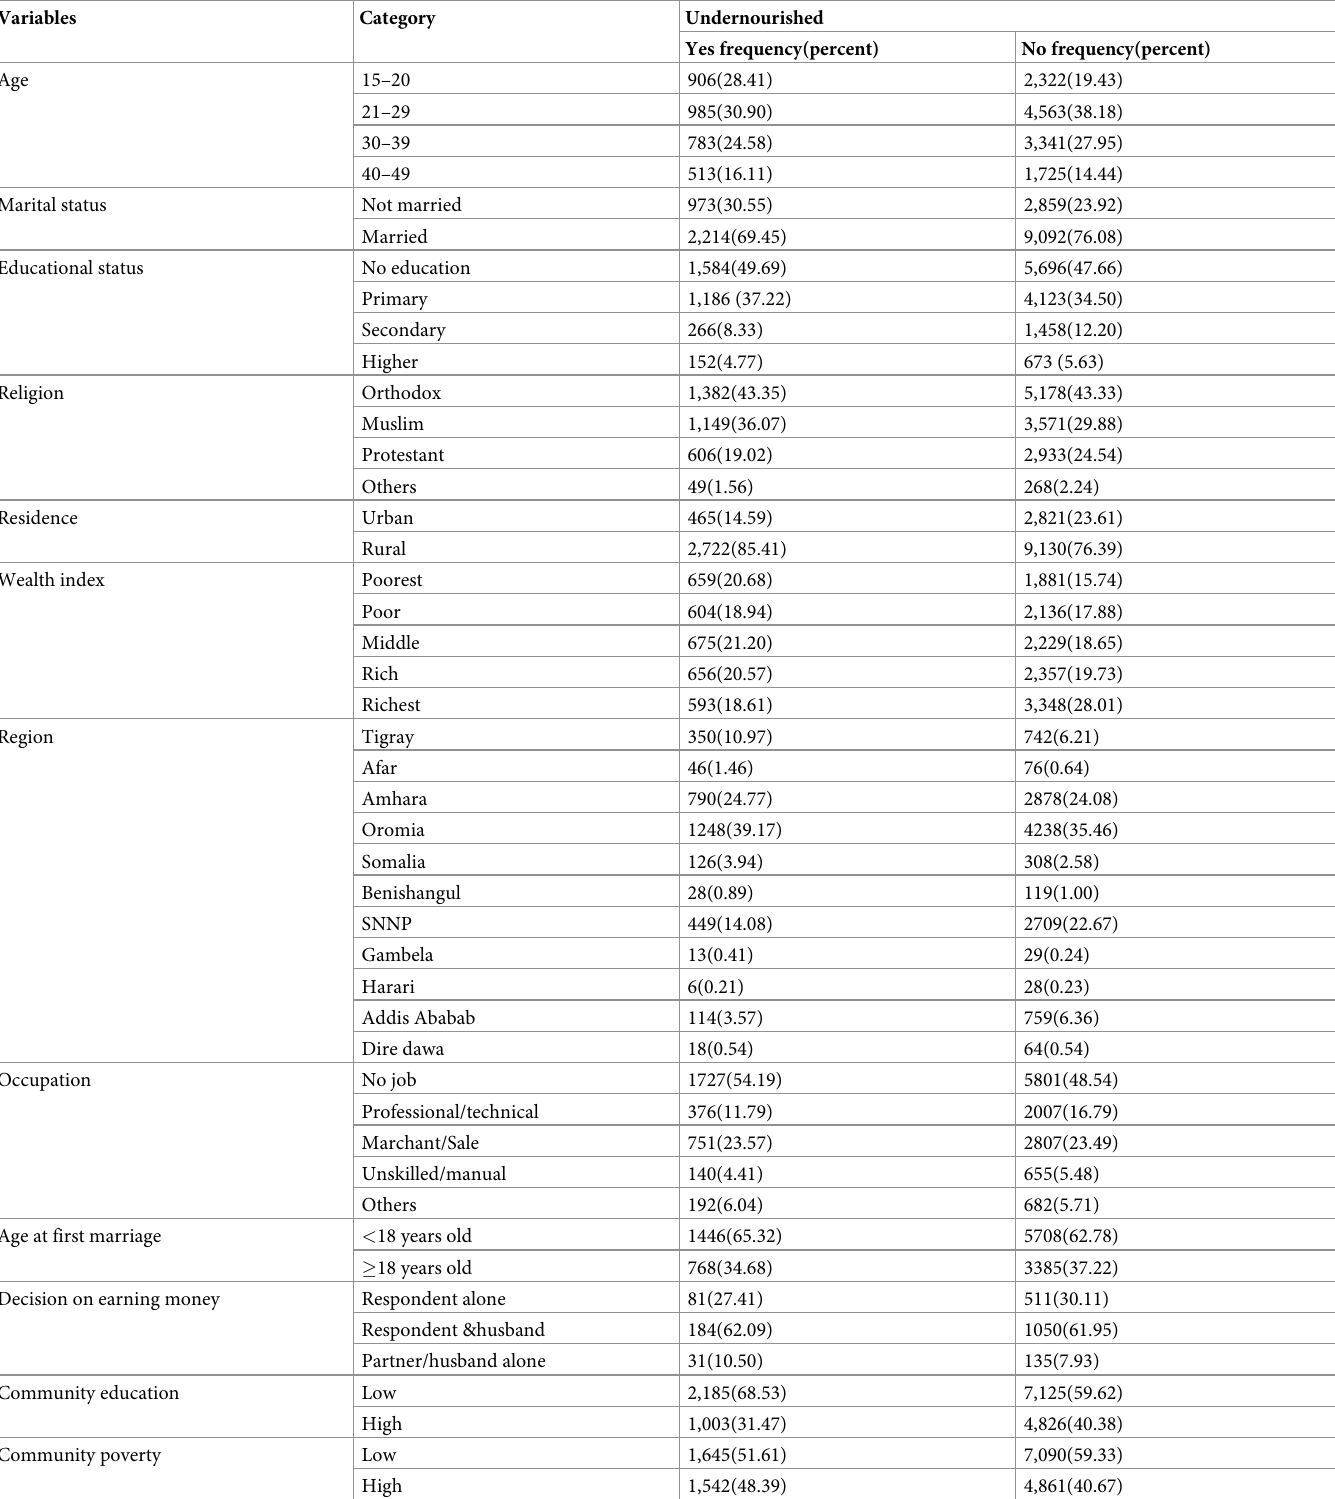
Table 1. Socio- demographic and economic characteristics of participants, EDHS